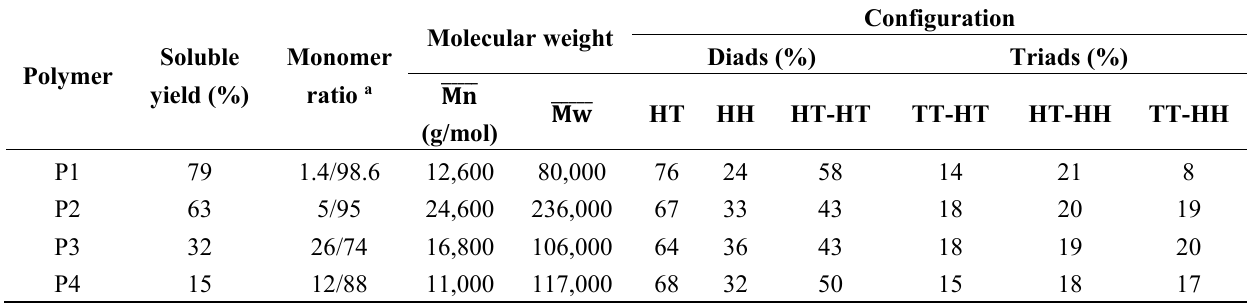
Table 1. Characteristics of copolymers P1, P2, P3 and